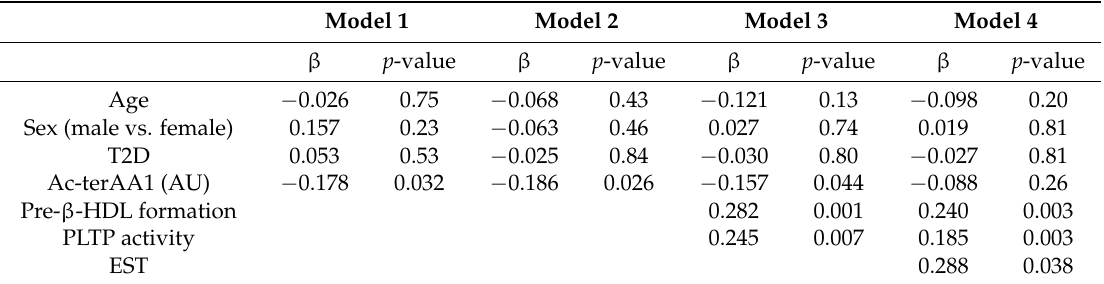
Table 4. Multivariable linear regression analysis showing the association of Ac-terAA1, expressed as optical density, with cholesterol efflux capacity in 150 subjects.